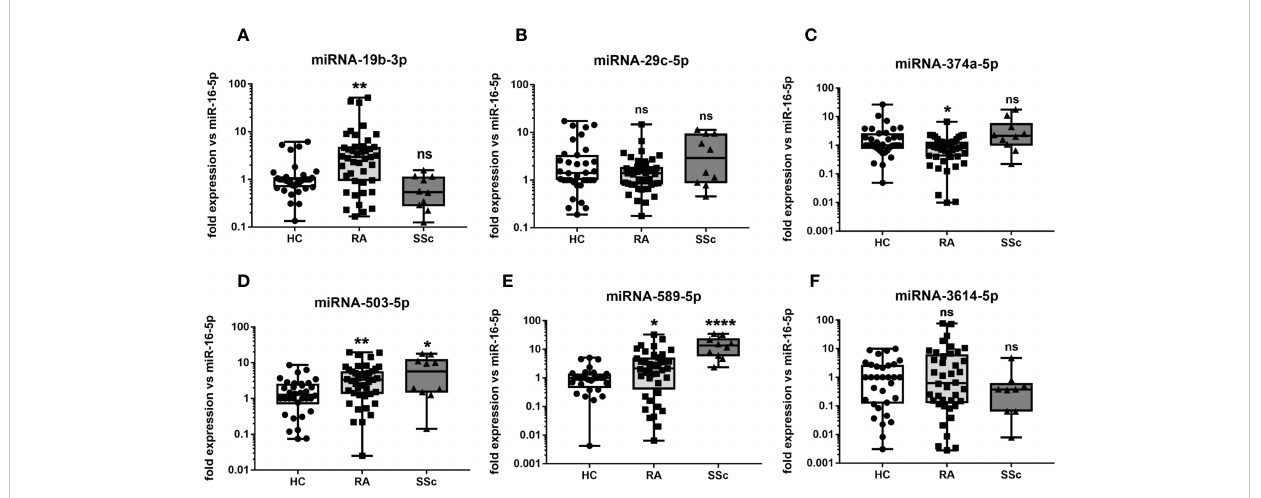
FIGURE 2 The level of circulating miRNA in RA and SSc patients. The level of miRNA-19b-3p (A) , miRNA-29c-5p (B) , miRNA-374a-5p (C) , miRNA-503-5p (D) , miRNA-589-5p (E) , miRNA-3614-5p (F) in sera of RA and SSc patients compared to HC. P-values were expressed as follows: ns for not signi fi cant; 0.05 > P > 0.01 as *; 0.01 > P > 0.001 as **; P < 0.001 as ***, P <0.0001 as ****.